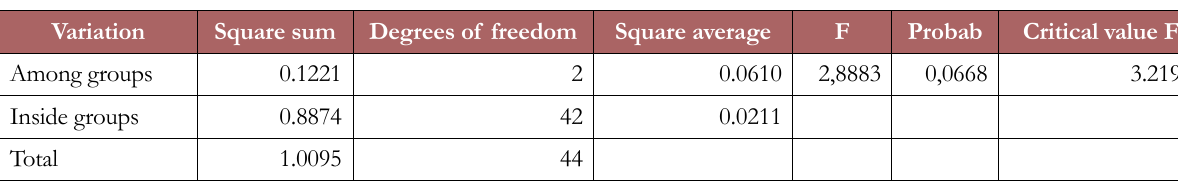
Table 10. Variance analysis. Television sets assembly case